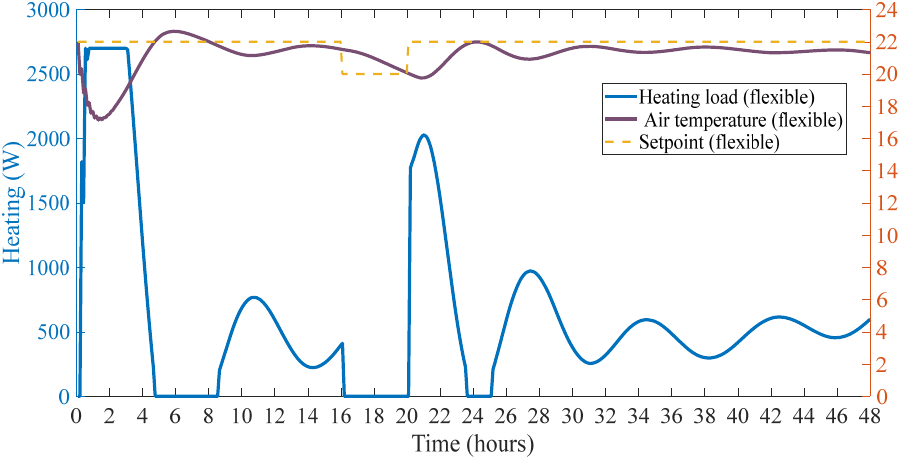
Figure 12. Downward flexible case for air temperature control.